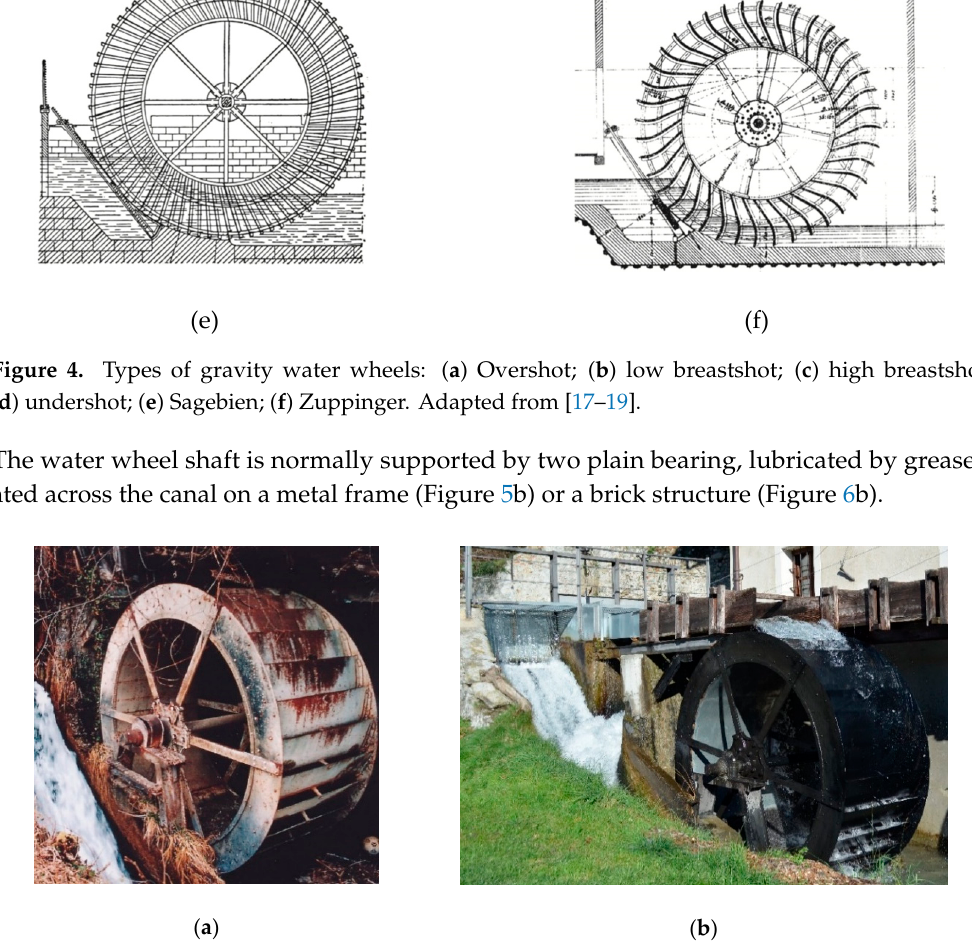
Figure 5. The overshot water wheels of the Riviera mill: ( a ) Before the renovation (Courtesy of Arch. Roberto Olivero, 2004); ( b ) after the renovation.